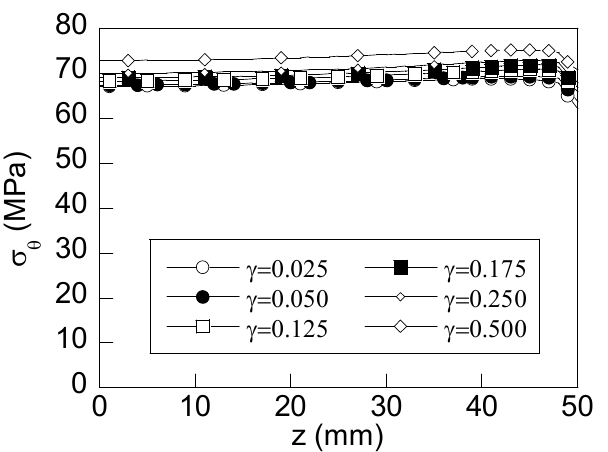
Figure 9. Axial distributions of the tangential stress at the interface contact of the ring/shaft for di- verse values of the thickness ratio.